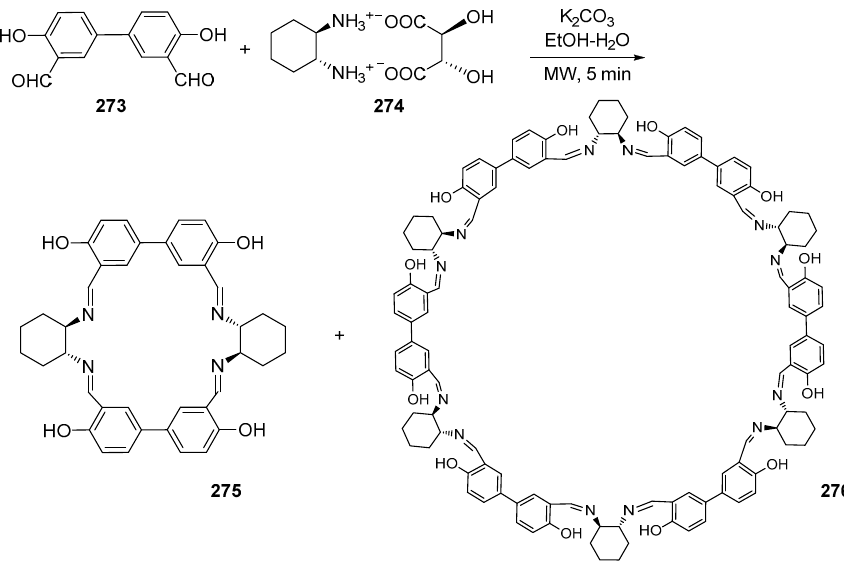
Scheme 56. First example of a MW-activated calix-type synthesis.